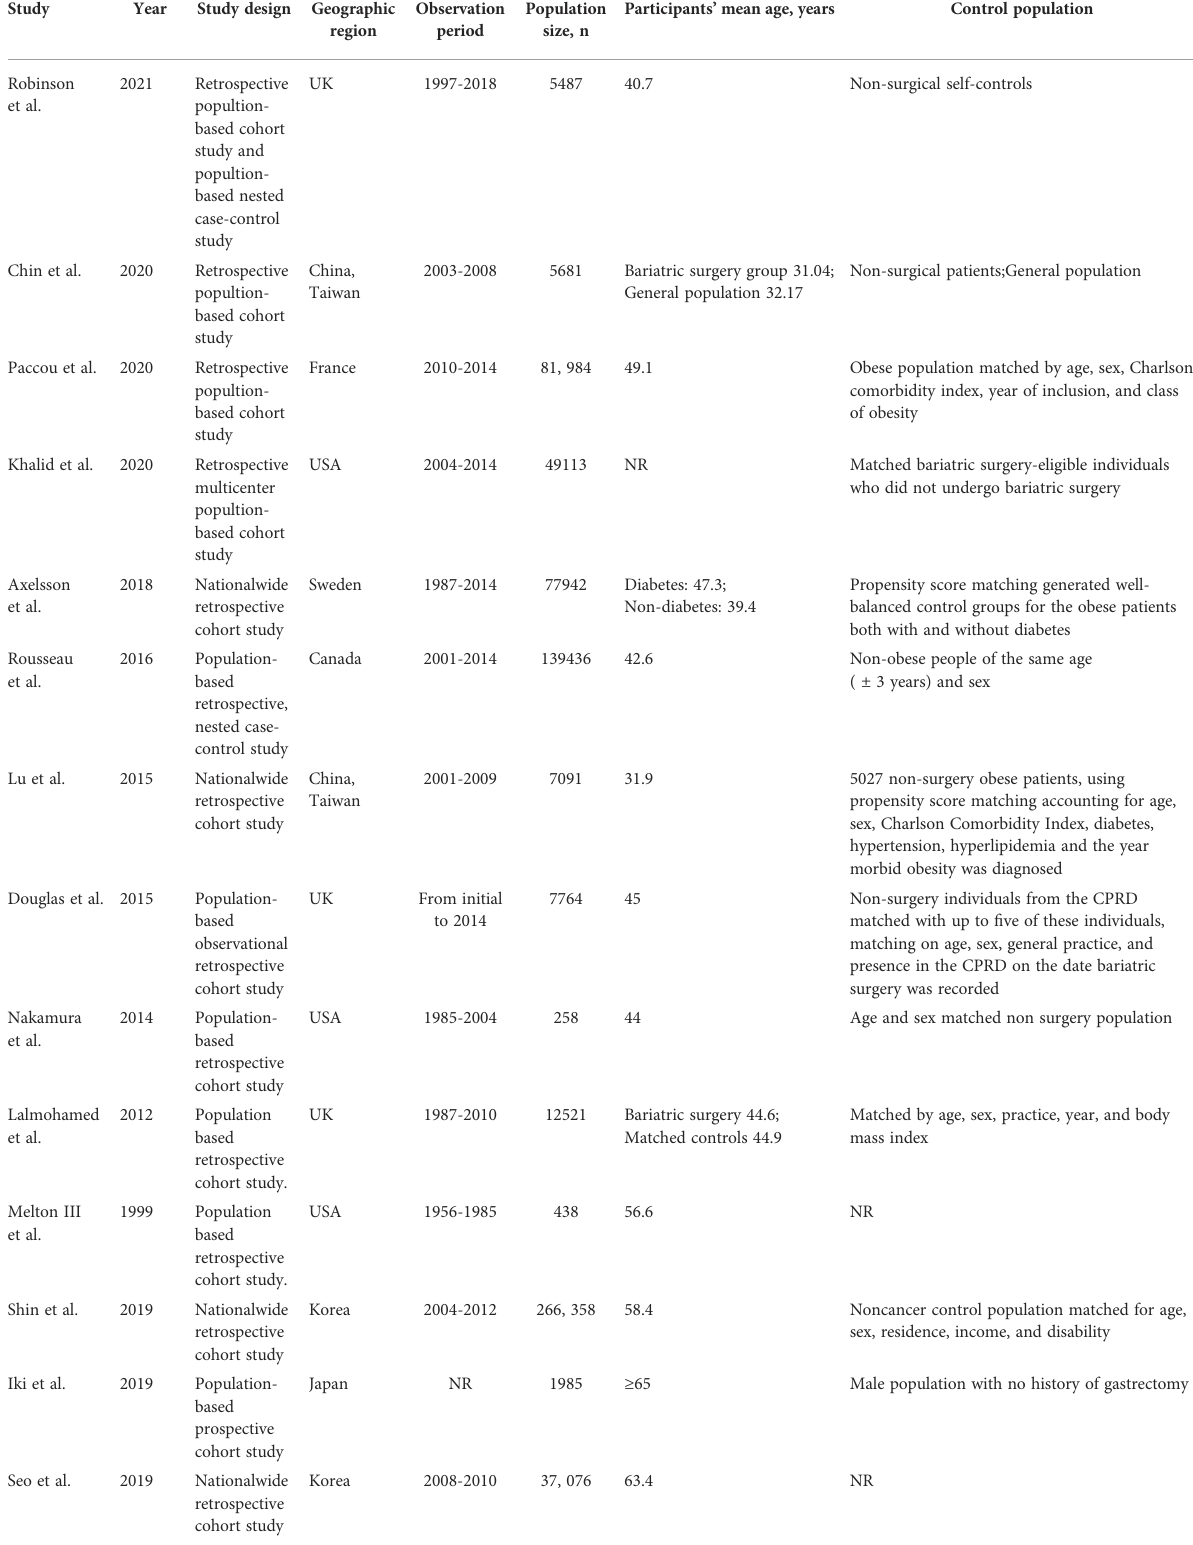
TABLE 1 Baseline characteristics of studies included in the analysis of associations of gastric surgery with subsequent fracture risk.